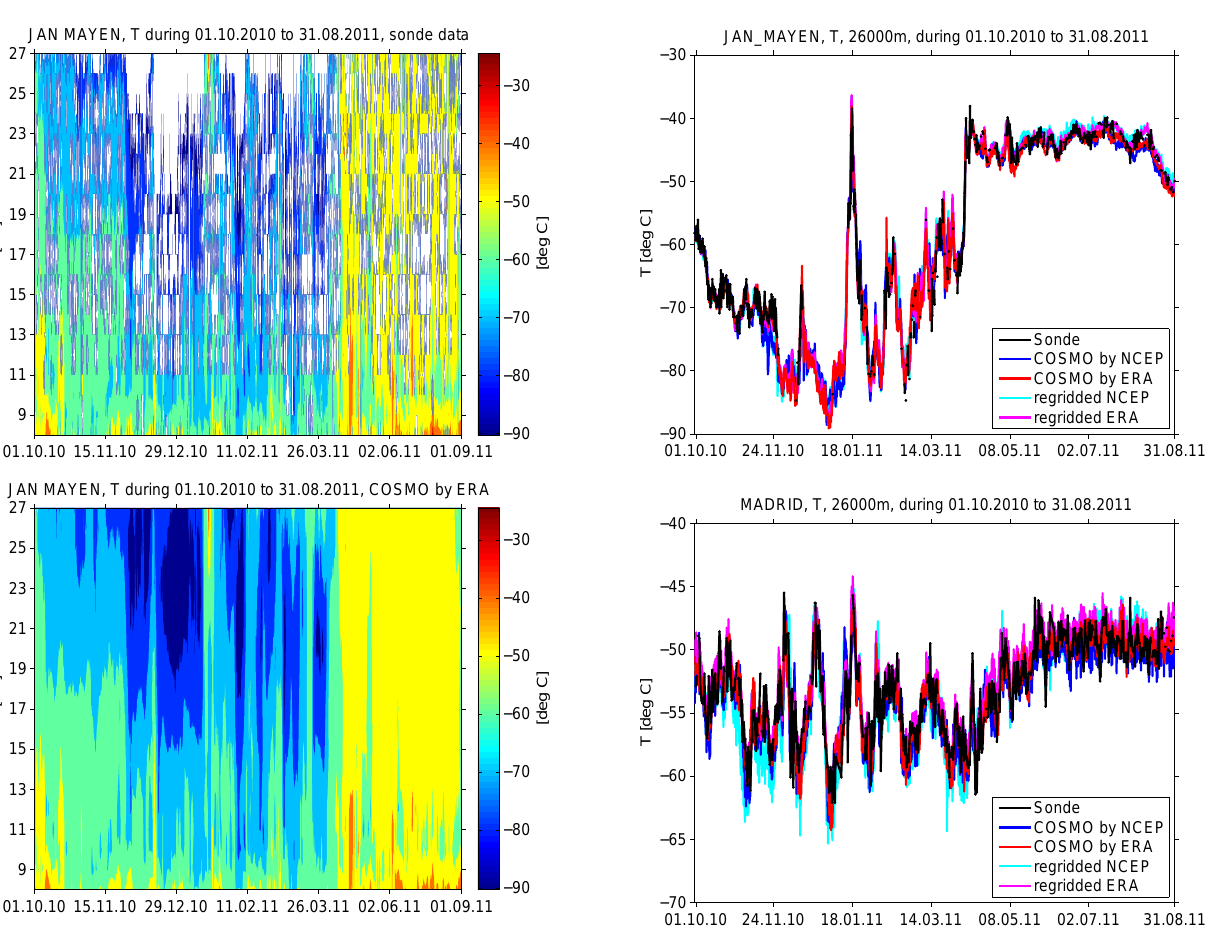
Figure 5. Time series of measured and modeled temperature, 26km above Jan Mayen (top) and Madrid (bottom). Interpolated reanaly- sis data are also